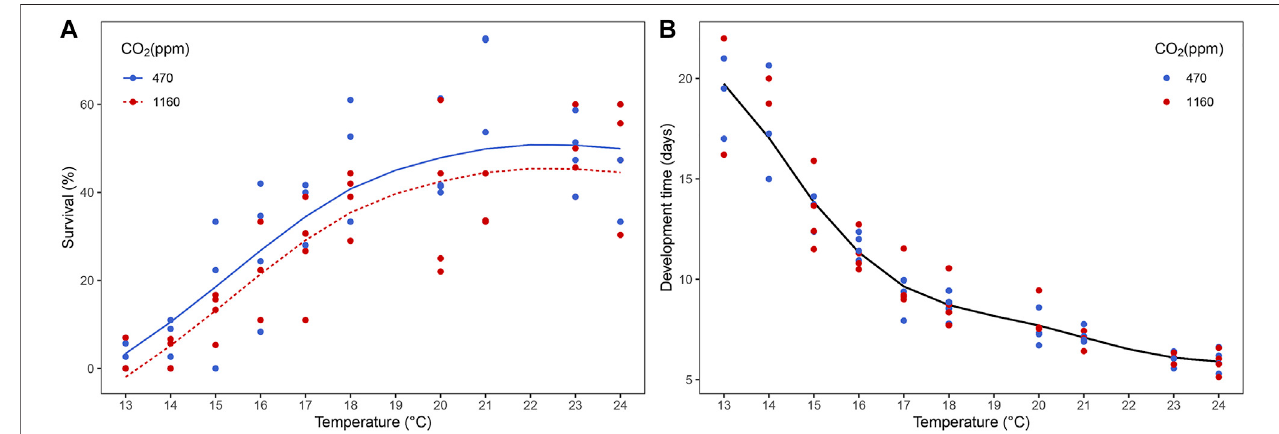
FIGURE1| Effectoftemperatureandoceanacidi fi cationonthesurvivalanddevelopmenttimeof Homarusgammarus larvaetostageIII. (A) survivalwasin fl uenced by CO 2 and temperature, (B) development time was in fl uenced by temperature. Each point represents the average response quanti fi ed in larvae originated from the same female. Curves correspond to smooths fi tted with the best (general additive) model, obtained after backwards model selection.